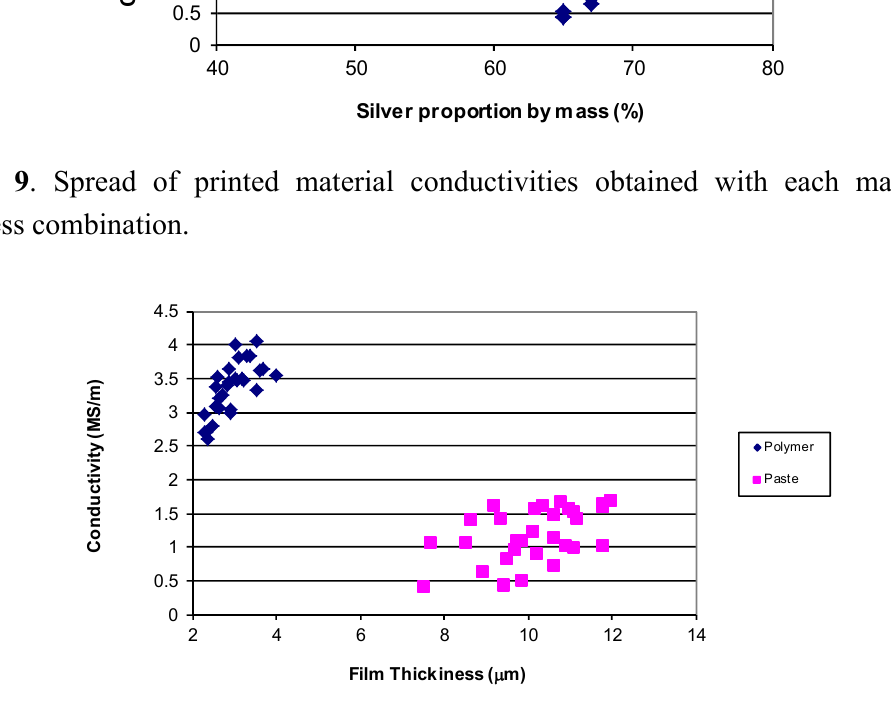
Figure 10 . Spread of material conductivities obtained with each material/film thickness combination.